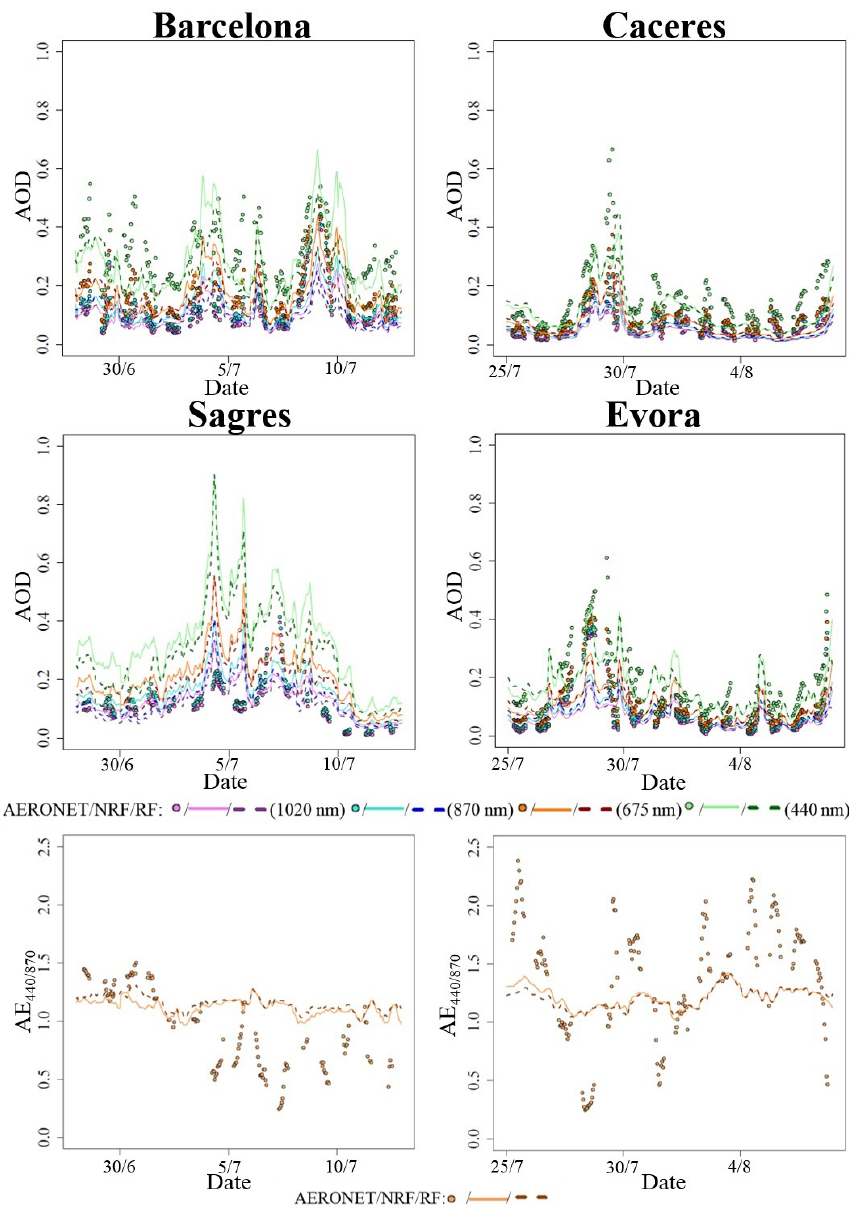
Figure 11. AERONET (dots), NRF (line) and RF simulations (dashed line). AOD at different AERONET wavelengths: Barcelona (top left) and Sagres (top right) stations for the dust episode (from 28 June to 12 July) and Caceres (centre left) and Evora (centre right) stations for the fire episode (from 25 July to 7 August). AE 440 / 870 in the Sagres station for the dust episode (from 28 June to 12 July, bottom left) and for the Caceres station for the fire episode (from 25 July to 7 August, bottom